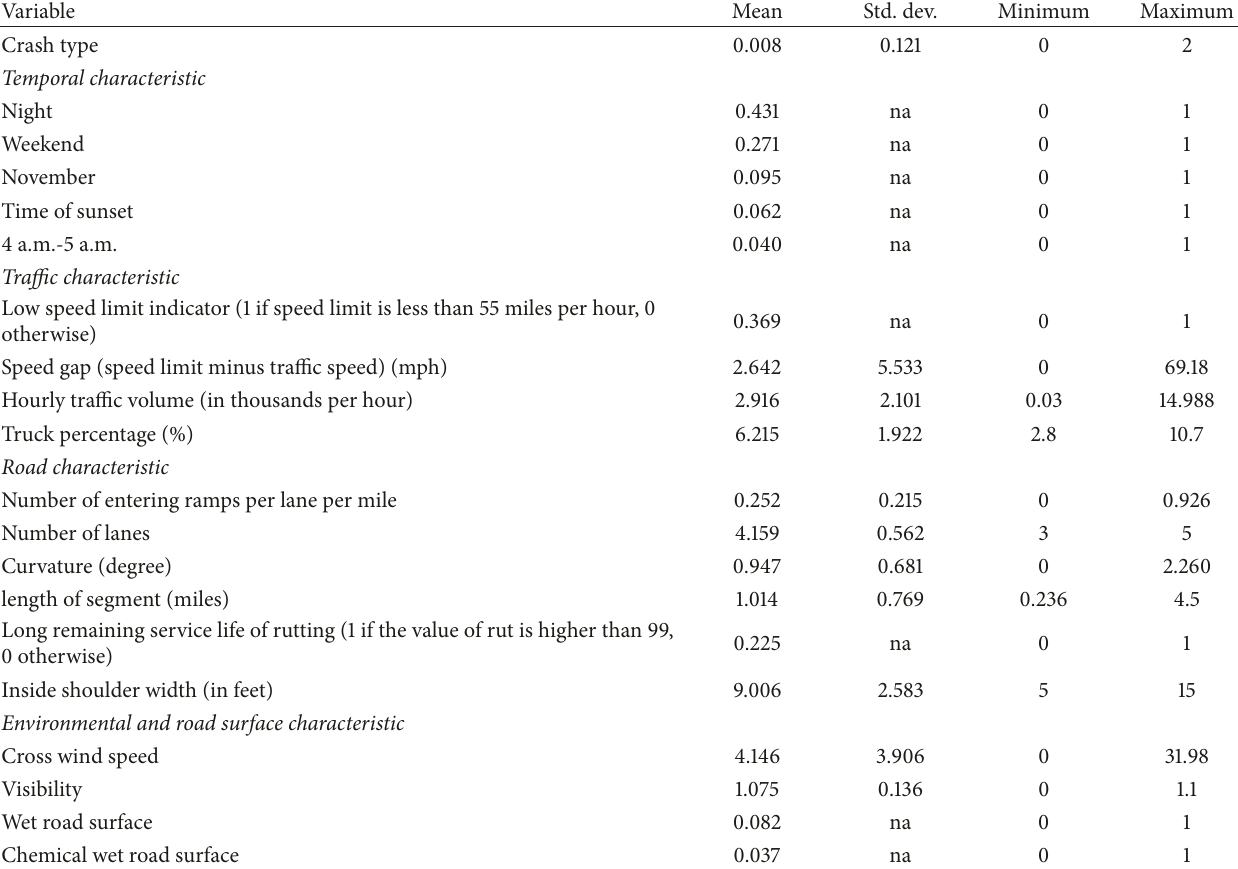
Table 1: Descriptive statistics of response and significant explanatory